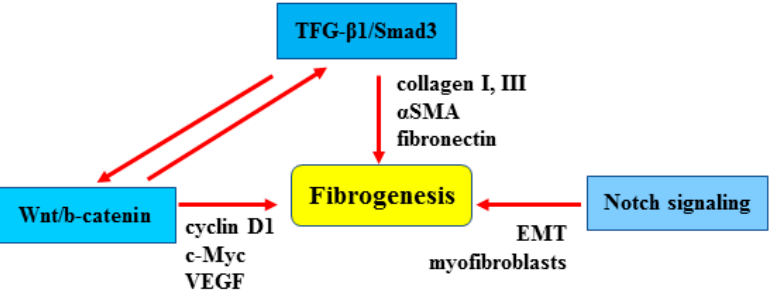
Figure 3. The Wnt/ β -catenin, TGF- β 1/Smad3 and Notch pathways contribute to fibrogenesis by stimulating myofibroblast differentiation and proliferation in order to produce extracellular matrix components.